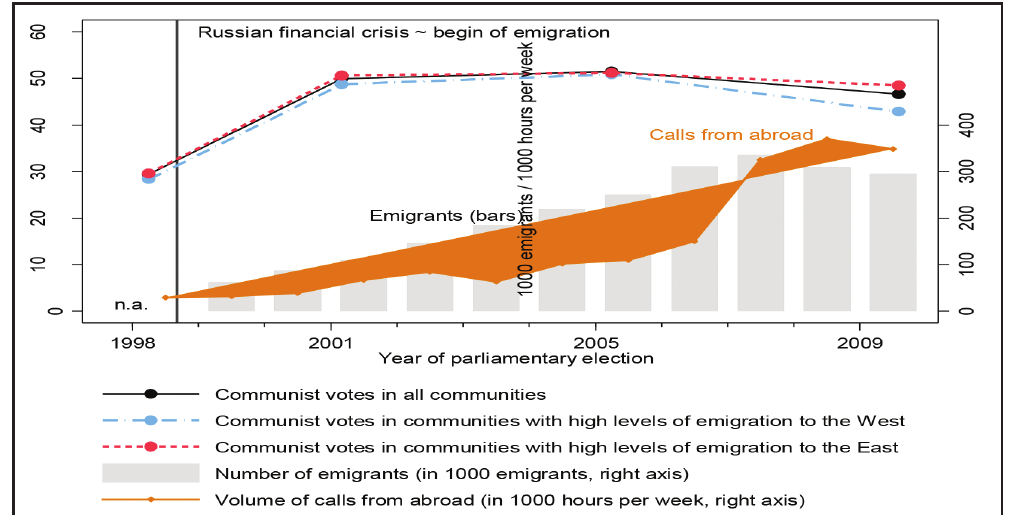
Emigration and political change in Moldova, 1998–2009